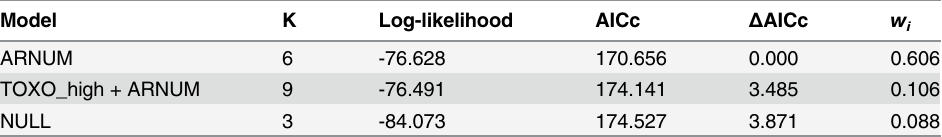
Table 6. Performance statistics of three top models of pathogen and toxicant exposure factors relat- ing to ultimate cause of mortality for 67 fishers ( Pekania pennanti ) within the two isolated populations, northern California and southern Sierra Nevada. The one factor in the final model was ARNUM (number of different types of anticoagulant rodenticides to which the fisher was exposed). TOXO_high refers to expo- sure to T . gondii using the isotype